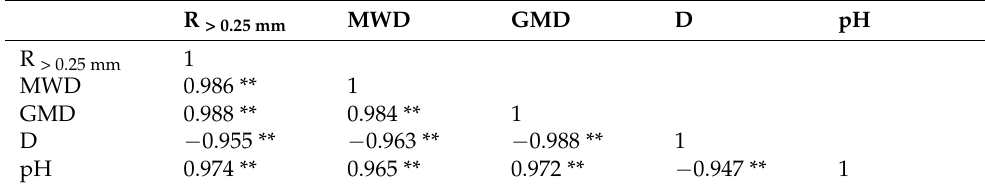
Table 3. Correlation analysis of soil pH with soil macroaggregate content and aggregate stability indexes.